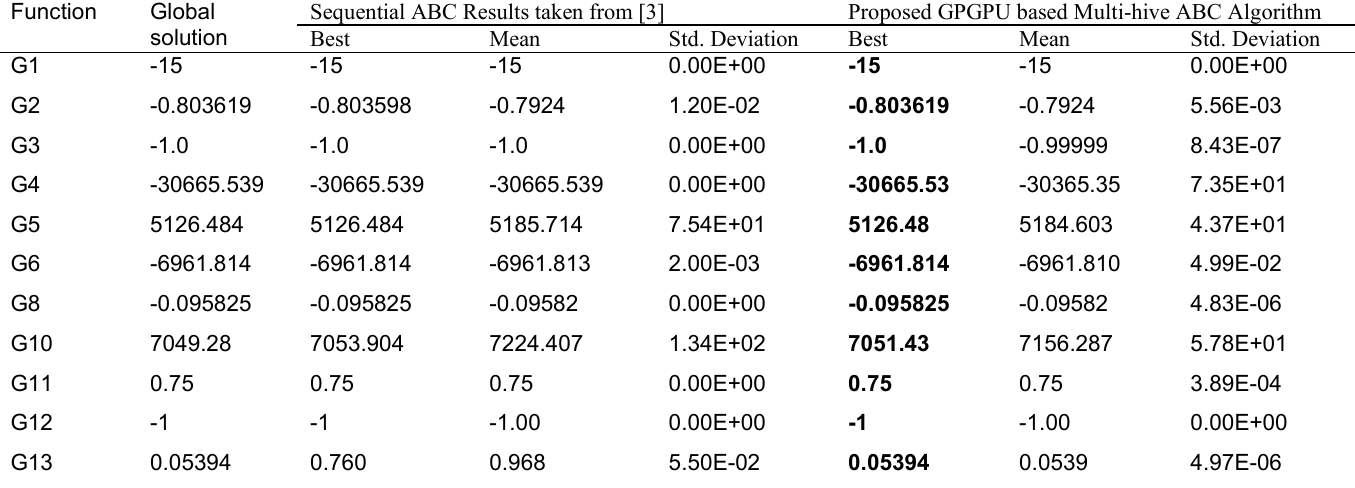
Table 3. Comparison of Sequential ABC and Proposed GPGPU based multi-hive ABC Algorithm Sequential ABC Results taken from [3] Proposed GPGPU based Multi-hive ABC Function Global solution